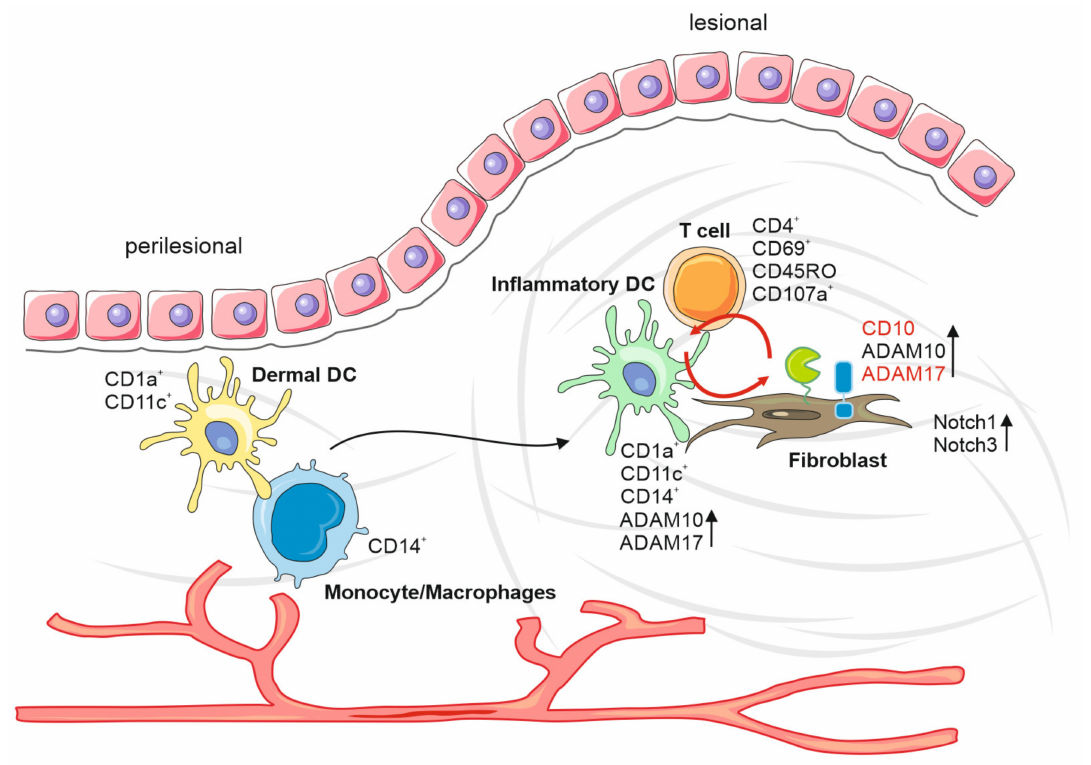
Figure 6. Keloid formation model. Increased DC precursor cells from perilesional vessels, attract by autoimmune antigens during the wound healing process, migrate to lesional areas and develop into inflammatory DCs. The interaction between inflammatory DCs, T cells, monocytes and fibroblasts results in an increased protease expression. This inflammatory environment leads to increased expression of proteases and their precursor effectors, such as the Notch receptors, leading to several stimulating effects, including the proliferation of fibroblasts and production of extracellular matrix